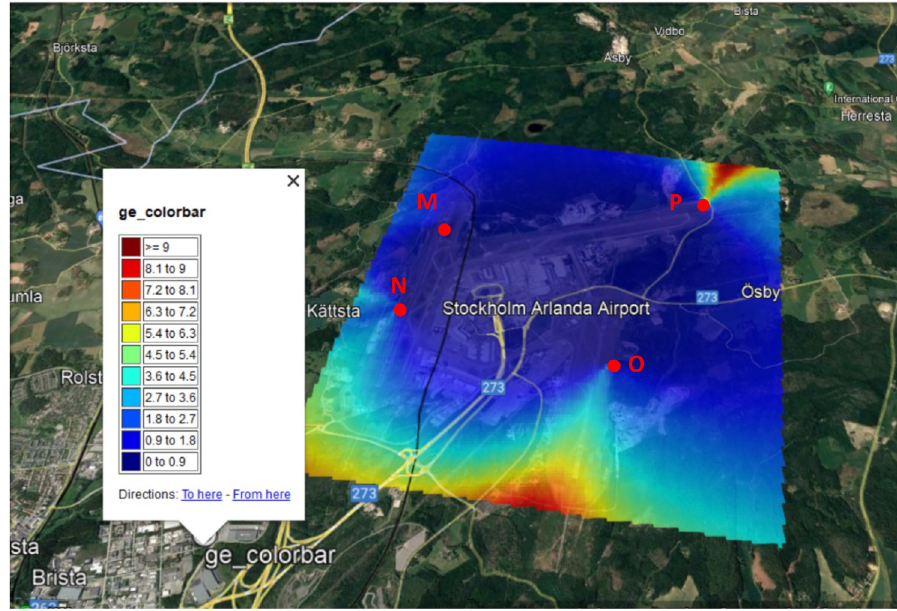
Figure 3: DOP of the wireless security network based on the initial design of the ANs over the Arlanda international